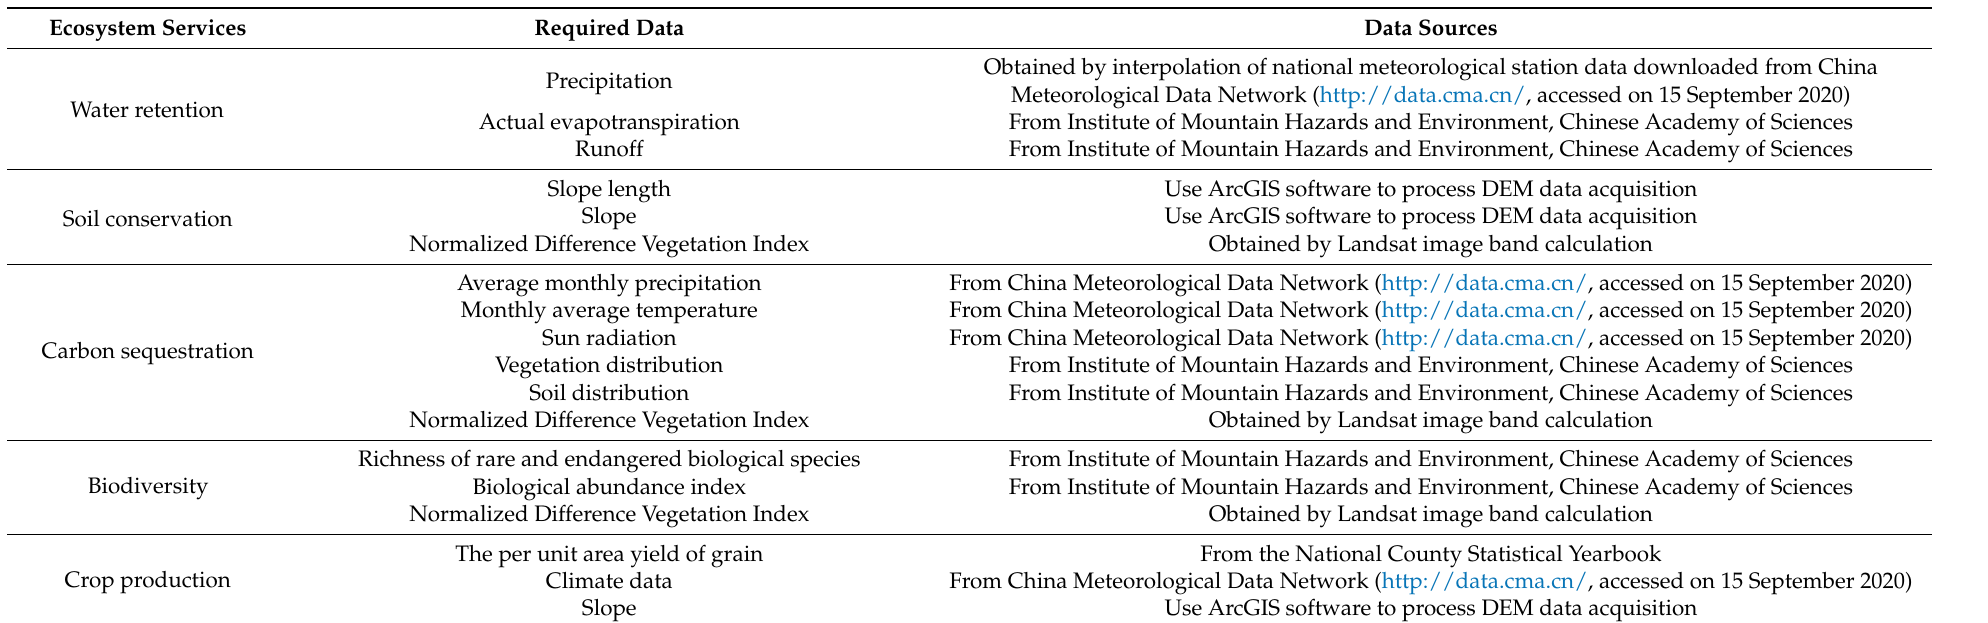
Table 1. The data sources required by the ecosystem service assessment